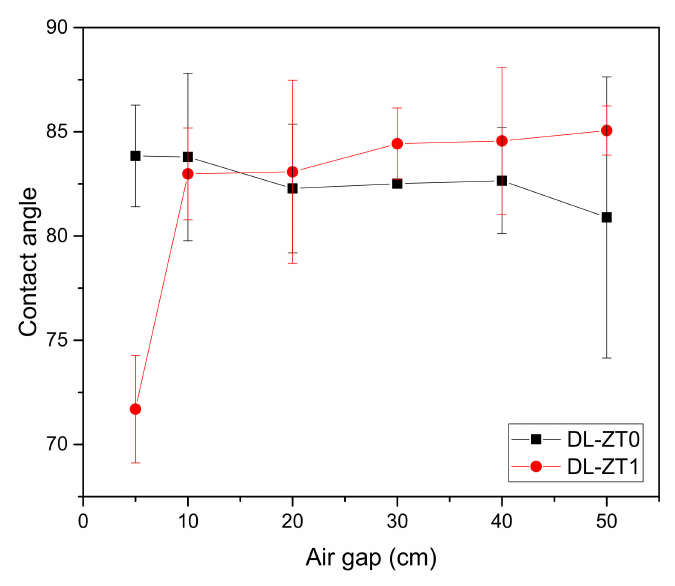
Figure 9. Contact angle measurement with increasing air gap